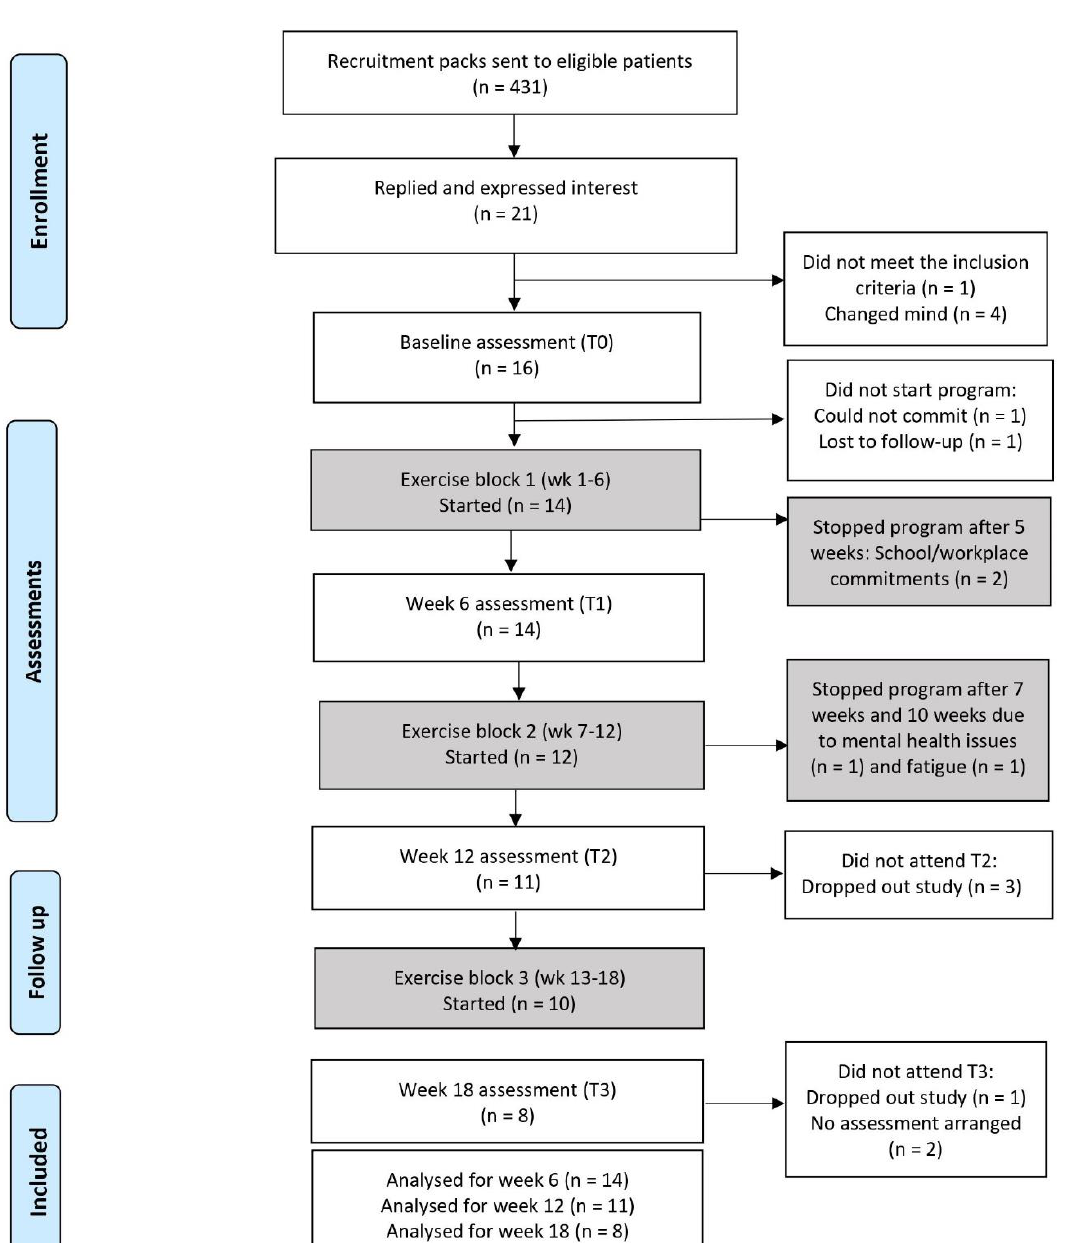
Figure 1. Flowchart of the participants in the study for both the participation in the exercise program (shaded boxes) and in the study assessments (white